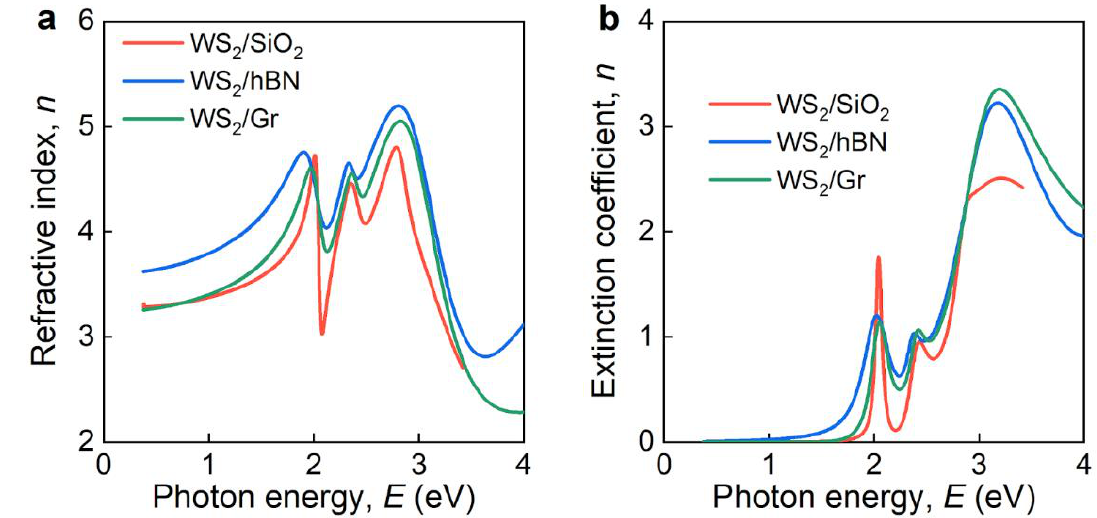
Figure 4. Optical constants of monolayer WS 2 in heterostructures. ( a ) Refractive index and ( b ) extinction coefficient.